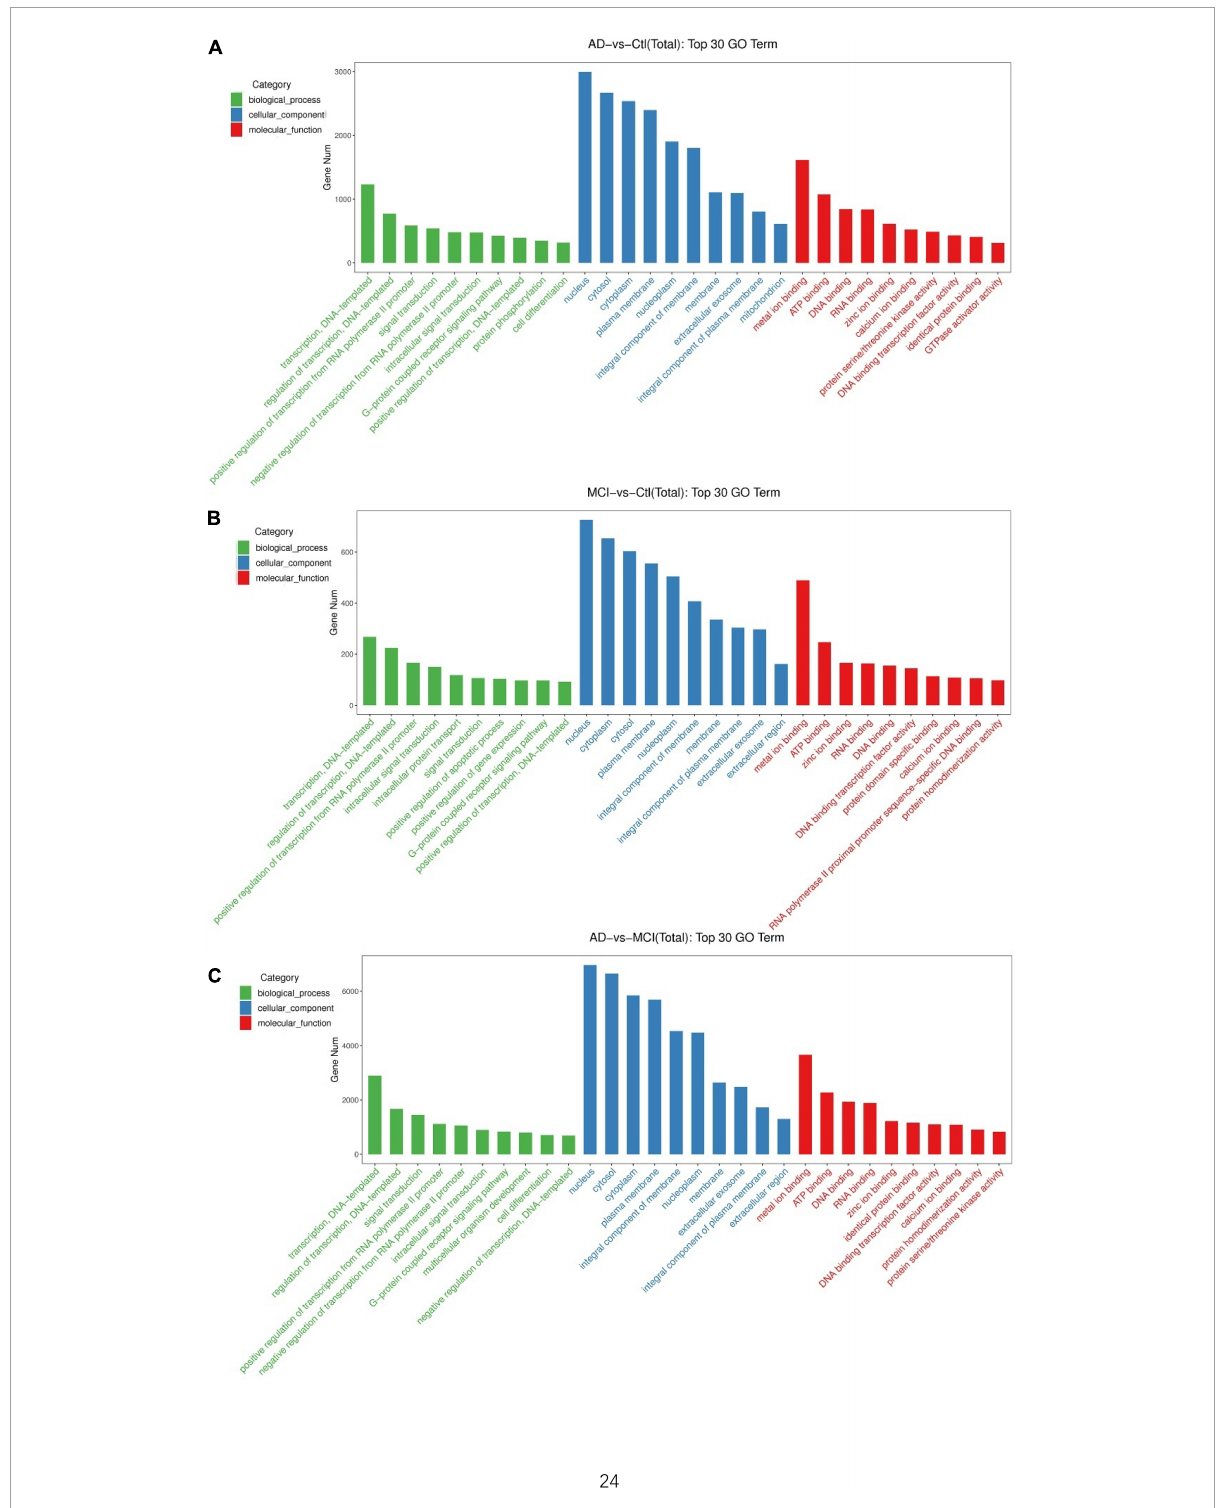
FIGURE3 GO analyses of predicted targets of DECEmiRs during AD progression. (A–C) The top 10 significant GO terms of biological processes (green bars), cellular components (blue bars), and molecular functions (red bars) of the predicted targets of DECEmiRs in AD vs. Control comparison (A) , MCI vs. Control comparison (B) , and AD vs. MCI comparison (C) . The Y-axis shows the gene numbers and the X-axis shows the GO